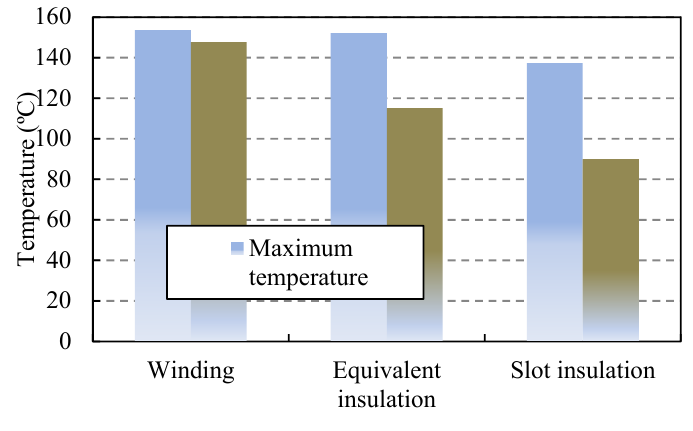
Figure 13. Maximum and average temperatures in the slot.